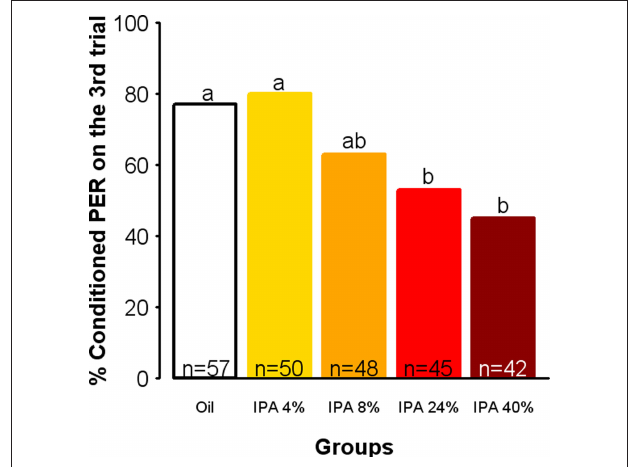
Figure 3 | exposure to iPA impairs learning in a dose-dependent manner. Learning performances, as indicated by percentages of conditioned PER to the conditioned odor on the third trial (PER conditioning). Independent groups were exposed to mineral oil only or to IPA at a given concentration (4, 8, 24, or 40% w/w in oil). As compared with controls ( Oil ), groups of bees exposed to increasing IPA concentrations show an increasing learning impairment, which reaches the significance level for the higher doses. Different letters indicate significant differences compared with controls ( α = 0.0125).